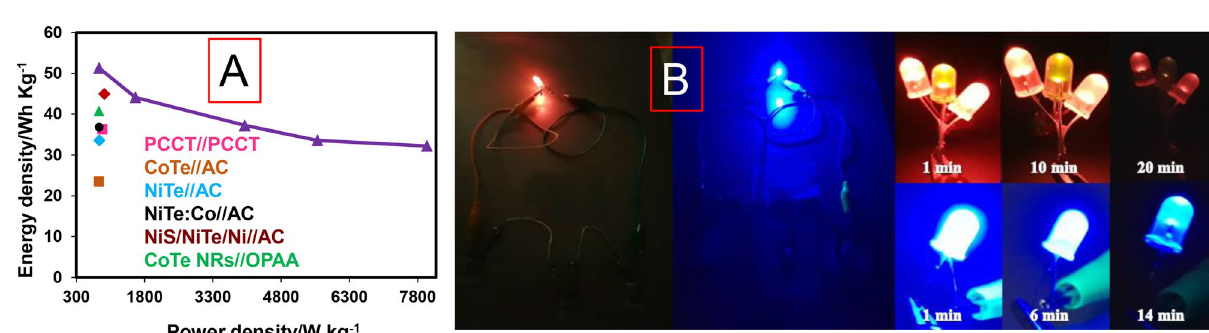
Figure 6. ( A ) Ragone plot of NiTe 2 -Co 2 Te 2 @rGO//AC HSC device vs. other Te-based//AC HSC devices 18,22,34–37 and ( B ) The yellow and two red LEDs (8 mm) connected in parallel, and a blue LED (8 mm) turned on by three NiTe 2 -Co 2 Te 2 @rGO//AC HSC